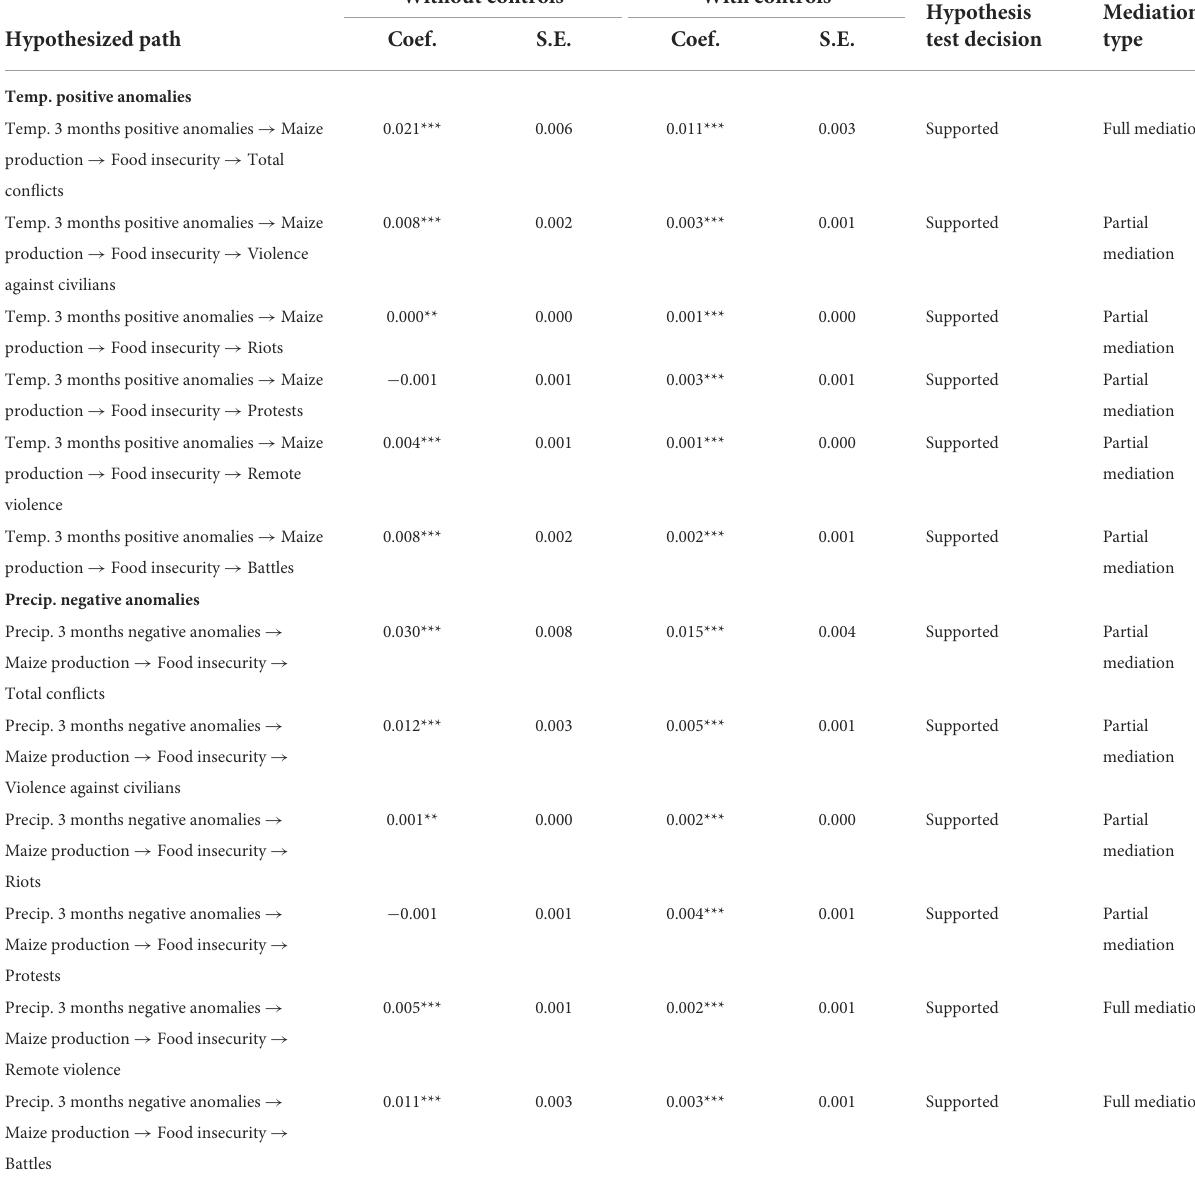
TABLE 2 Results of the serial mediation analysis showing indirect effects of climate on conflict via maize production and food insecurity. The table reports the results of the model without (col. 2) and with (col. 3) control variables. Column 4 reports whether the results support the hypotheses of our theoretical framework presented in section 3. The last column shows whether the mediation is full (i.e. direct effects are not significant) or partial (i.e. direct effects are